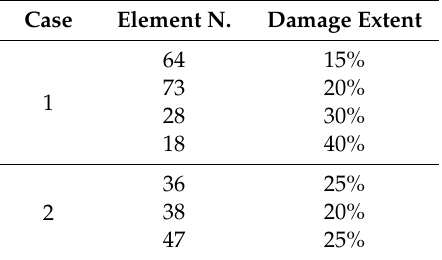
Table 1. Damage cases in numerical